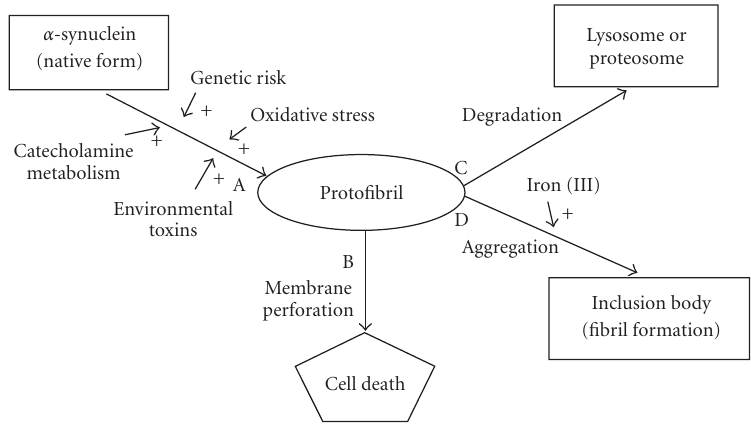
Figure 1: Possible mechanisms of neurodegeneration in